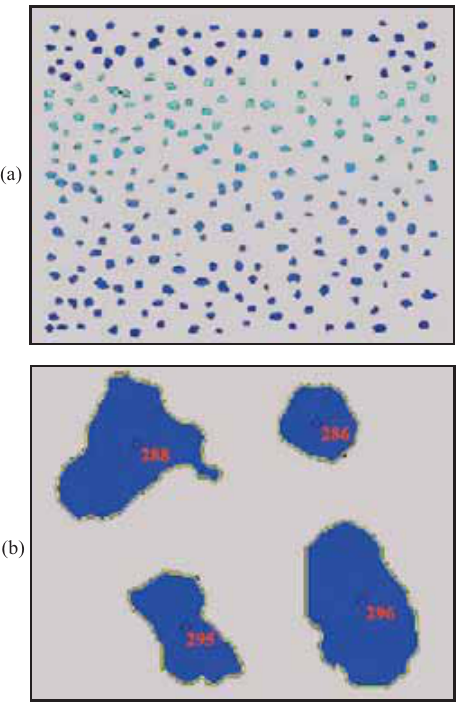
Figura 2. Imagem processada pelo programa UTHSCSA Image tool dos agregados da classe de tamanho de 1 a 2 mm do horizonte Bw2 do perfil 3 do Latossolo Bruno. (a) imagem original processada; e (b) imagem processada e ampliada ( zoom ), mostrando a numeração de cada agregado feita pelo